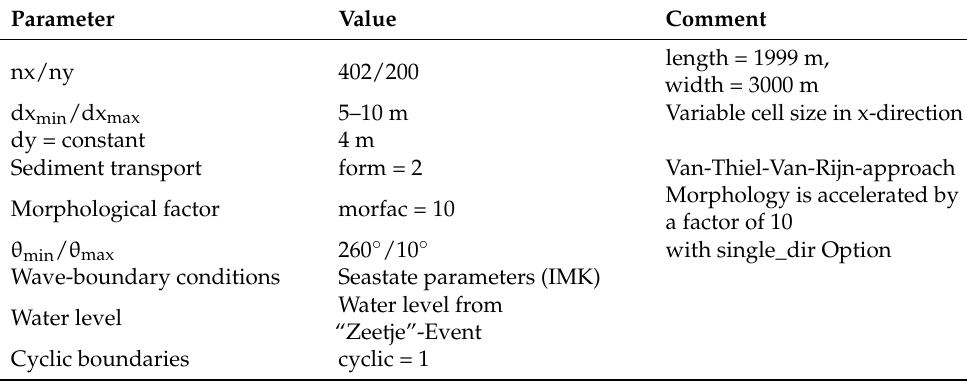
Table 3. XBeach model parameters and settings, Ahrenshoop, “Zeetje” storm